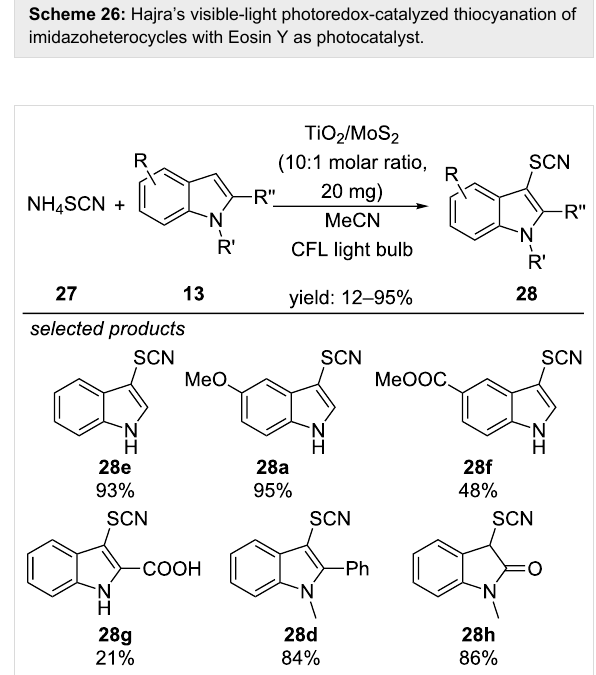
Scheme 27: Wang’s photoredox-catalyzed thiocyanation reaction of indoles, applying heterogeneous TiO 2 /MoS 2 nanocomposite as photo-